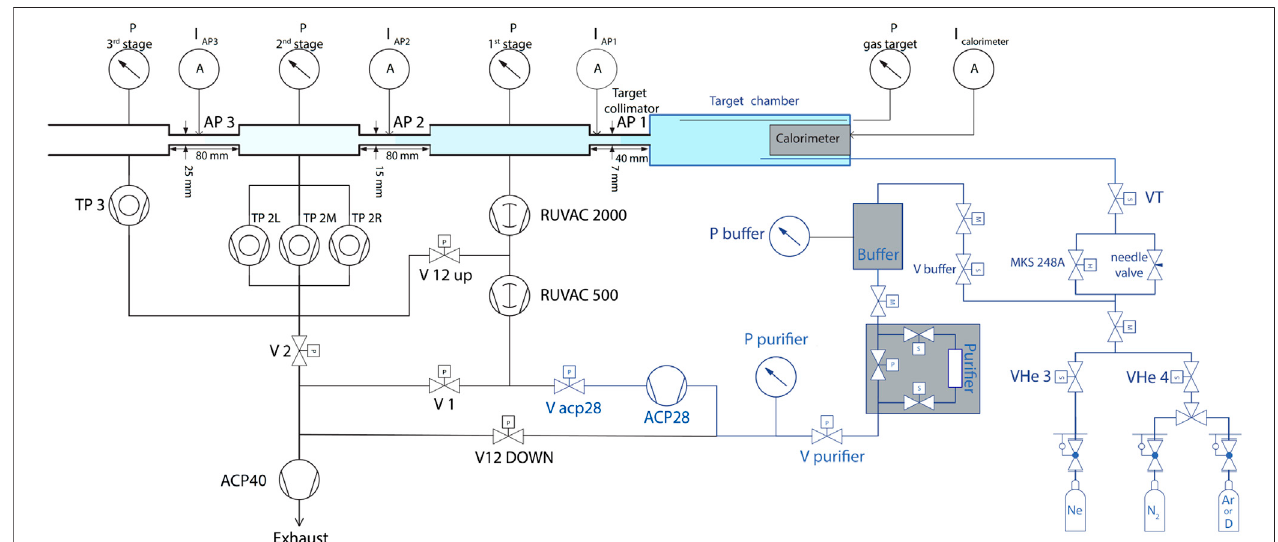
FIGURE1| Differentialpumpingsystemschematic.Thebeamcomesfromtheacceleratorontheleft,passesthroughtheaperturesAP3,AP2,andAP1,entersthe target chamber, and stops on the calorimeter.